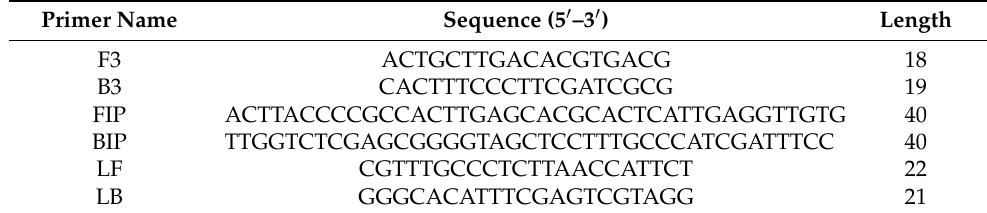
Table 2. Primers used for LAMP assays to detect F. oxysporum